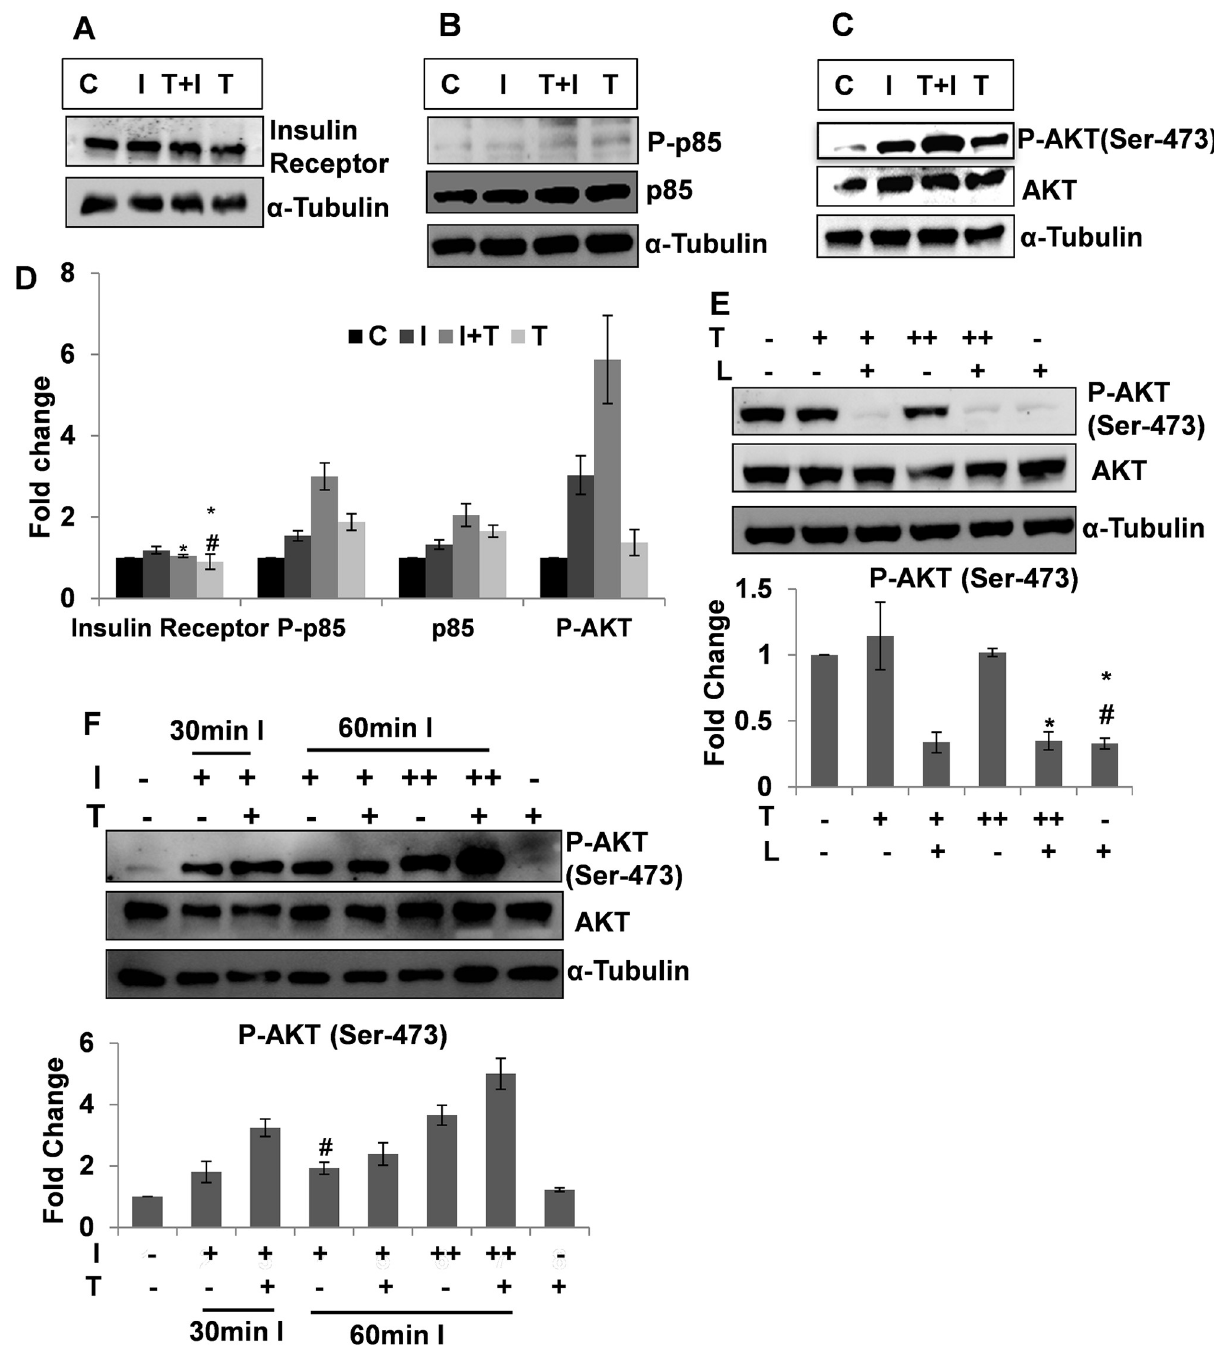
Fig 3. Testosterone potentiates insulin signaling in C2C12 cells. Immunoblot for Insulin Receptor (Fig 3A), P-p85 (Fig 3B) and P-AKT (Ser-473) (Fig 3C) in C2C12 cell lysate, C = control, I = Insulin (10ng/ml), I+T = Insulin (10ng/ml) +Testosterone (50ng/ml), T = Testosterone (50ng/ml). Testosterone pre- treatment was given for 60 min and insulin treatment for 60 min without removing testosterone. Fig 3D: Densitometry for Insulin Receptor, P-p85, p85, P-AKT (Ser-473) in C2C12 cell lysate, C = control, I = Insulin (10ng/ml), I+T = Insulin (10ng/ml) +Testosterone (50ng/ml), T = Testosterone (50ng/ml). Testosterone pre- treatment was given for 60 min and insulin treatment for 60 min without removing testosterone. The data were analyzed by two-way repeated measures ANOVA test followed by Bonferroni post hoc analysis; data represents mean ± S.D. of 3 independent experiments (n = 3), p < 0.05, � = no significant change as compared to C; # = no significant change as compared to I+T. Fig 3E: Immunoblot and densitometry for P-AKT (Ser-473) in C2C12 cells upon testosterone and/ or PI3K inhibitor treatment, T (+) = 50ng/ml Testosterone, T (++) = 100ng/ ml Testosterone, L (+) = 10 μ M LY294002; LY294002 added 15min prior to testosterone treatment, testosterone treatment was given for 60 min without removing LY294002; The data were analyzed by two-way repeated measures ANOVA test followed by Bonferroni post hoc analysis; data represents